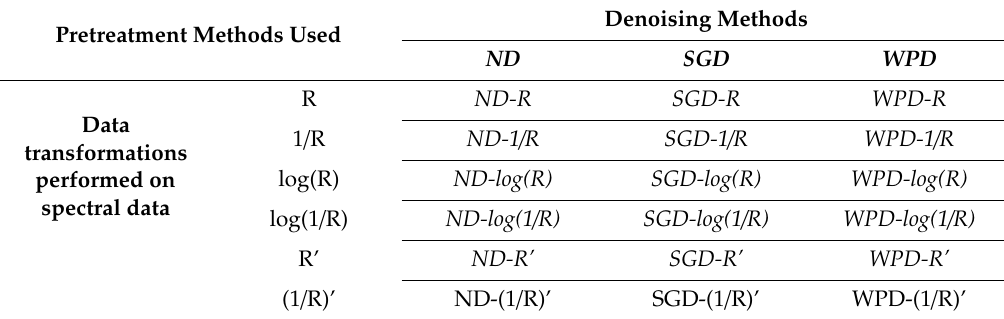
Table 3. Di ff erent Combinations of Pretreatments used in this